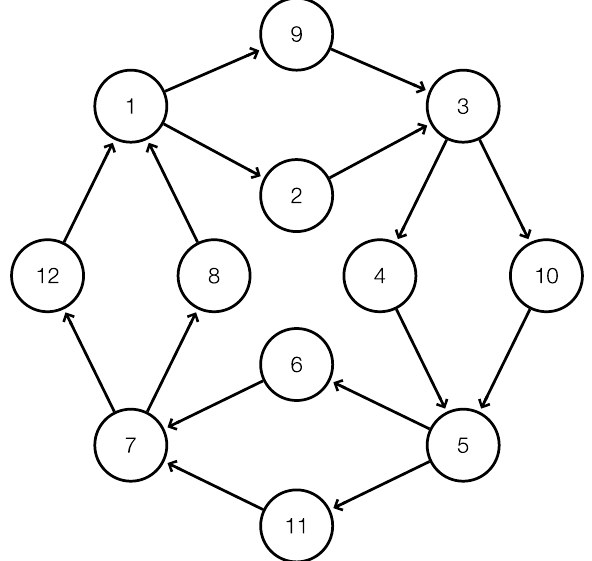
Figure 5. A digraph G without any legitimate root. In G are 16 isomorphic cycles containing eight of the 12 vertices, all of which contain { 1,3,5,7 } . The superbubbles (cid:104) 1,3 (cid:105) , (cid:104) 3,5 (cid:105) , (cid:104) 5,7 (cid:105) , and (cid:104) 7,1 (cid:105) cover G